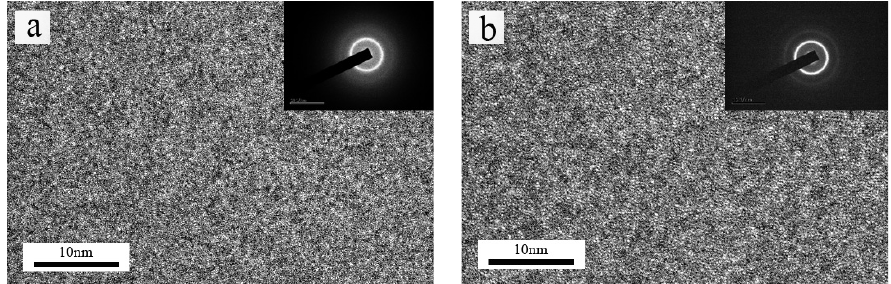
Figure 3. High- resolution TEM image inset with corresponding SAED pattern for ( a ) S25 and ( b ) S380.